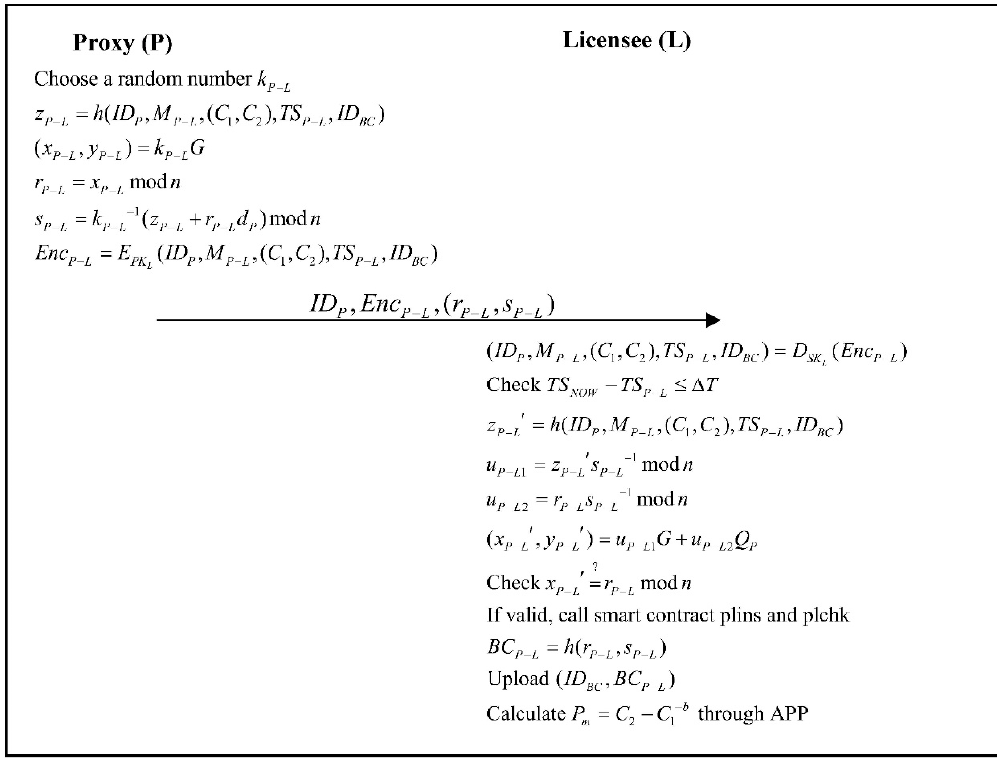
Figure 15. Payment verification and browsing phase (P to L). If the verification is passed, the proxy will get the relevant payment information and trigger the smart contracts lpins and lpchk. The content is as follows (Scheme